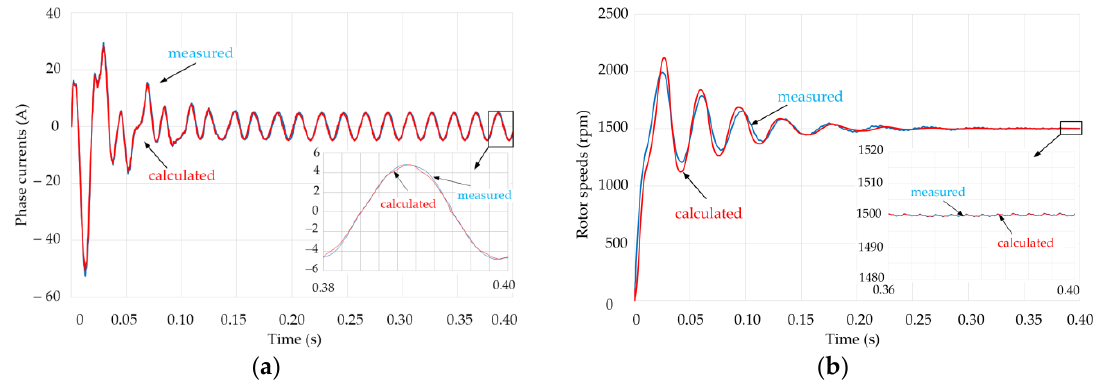
= 0.0082 = 0.0082 i i = 0.0082 i